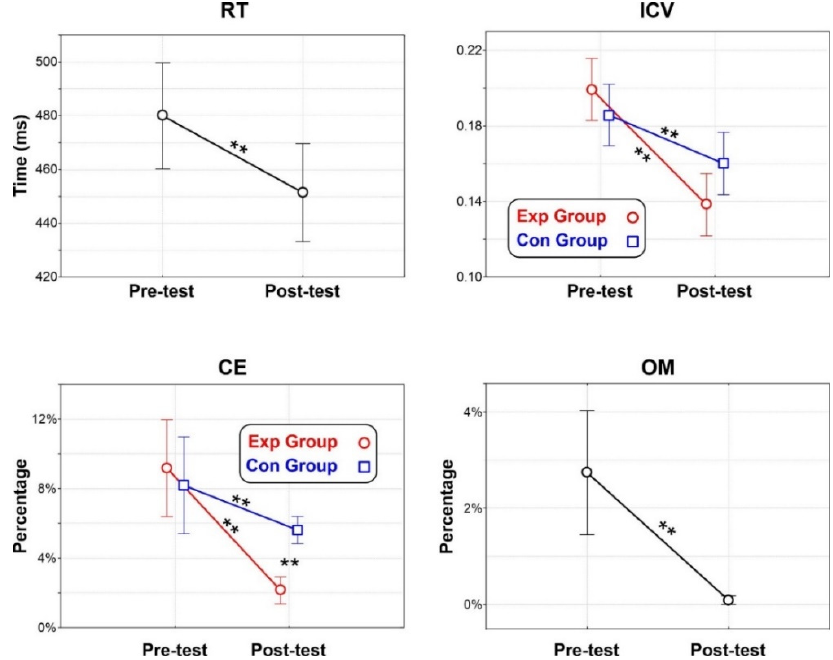
Figure 6. Behavioral results for response time (RT), intra-individual coefficient of variation (ICV), commission error (CE), and omission error (OM). Vertical bars denote 0.95 confidence intervals. ** = p < 0.01.